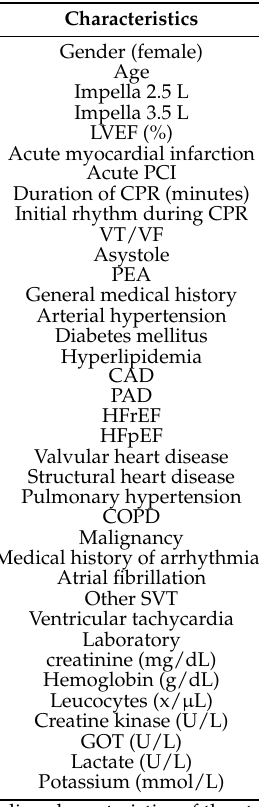
Table 1. Baseline characteristics and laboratory parameters before assist device